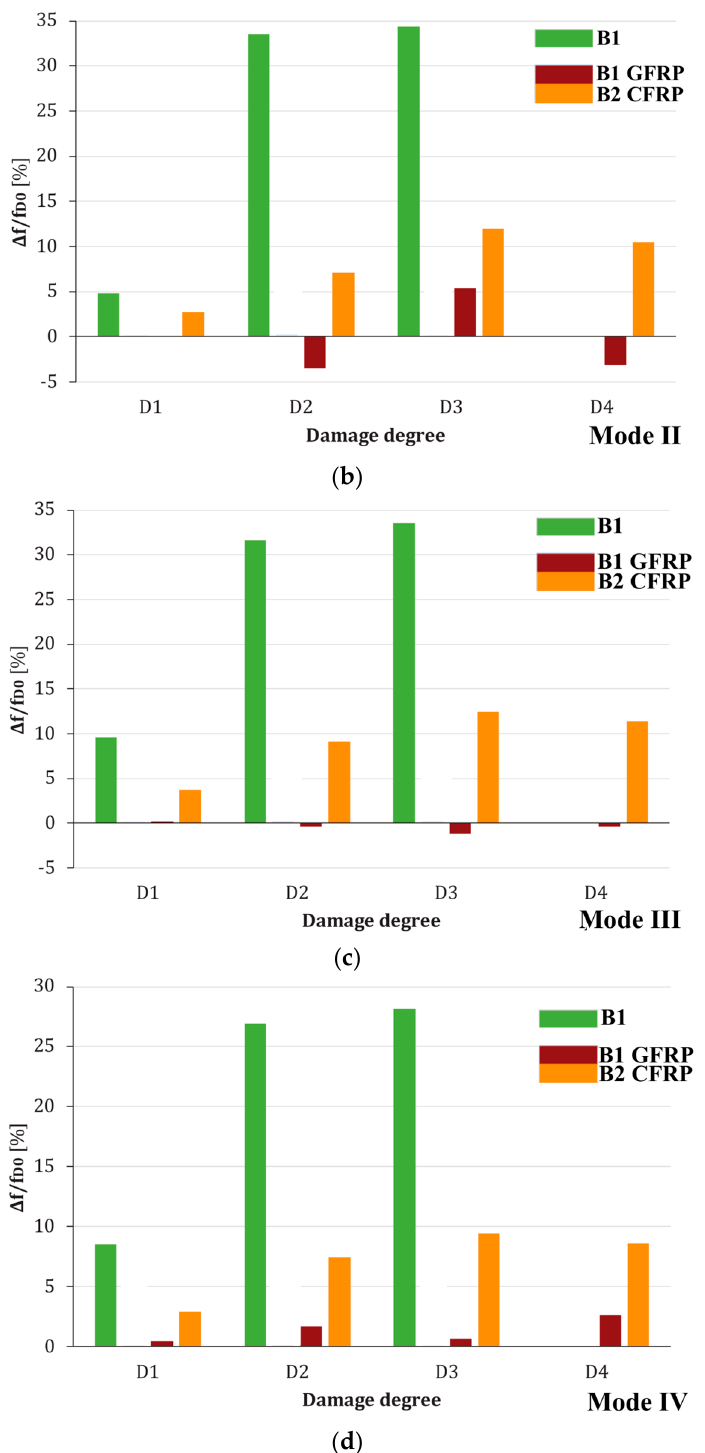
Figure 14. Comparison between frequency variation of beam models, at damage D i , compared to D 0 , for the fi rst four vibration modes: ( a ) mode 1; ( b ) mode 2; ( c ) mode 3; ( d ) mode 4.